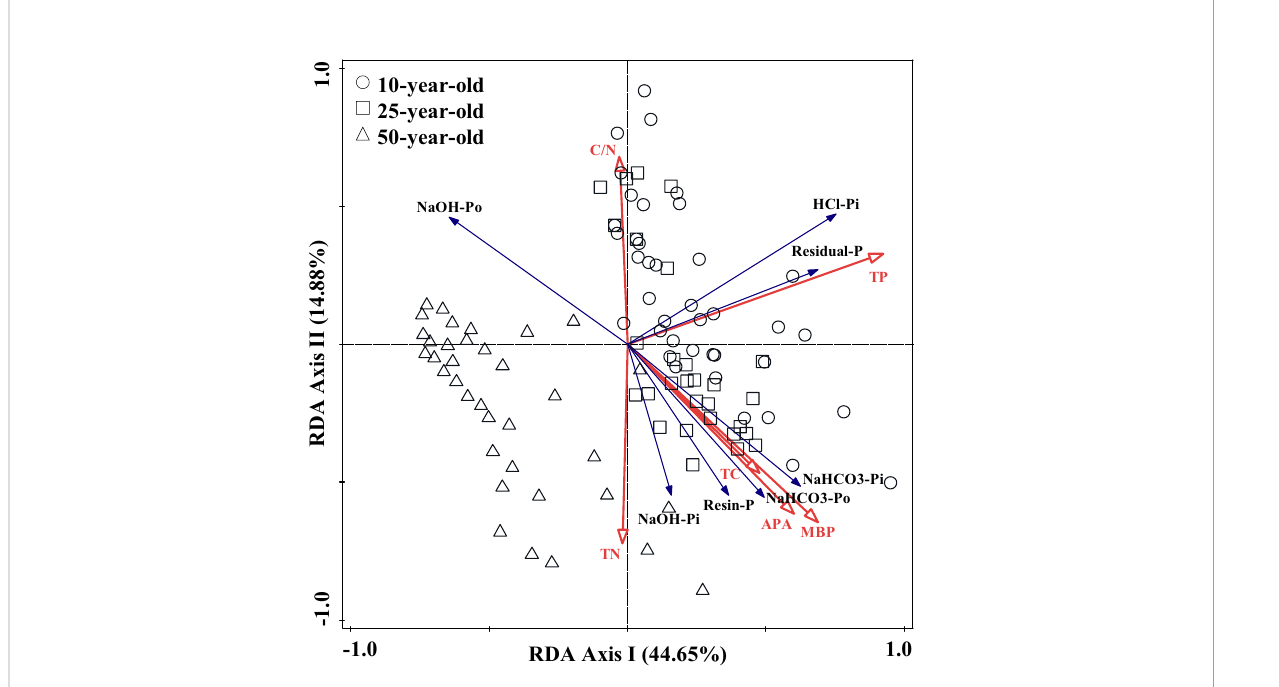
FIGURE 5 Redundancy analysis (RDA) on the relationships between soil phosphorus (P) fractions and environmental factors under different treatments in experiment 2. Blue and red arrows represent soil P fractions and environmental factors, respectively. The length and angle of lines indicate relationships between soil P fractions, environmental factors, and principal component analysis (PCA) axes; n = 108. Abbreviations: TP, total phosphorus; MBP, microbial biomass P; APA, acid phosphatase activity; TC, total carbon; TN, total nitrogen; C/N, total carbon/total nitrogen.